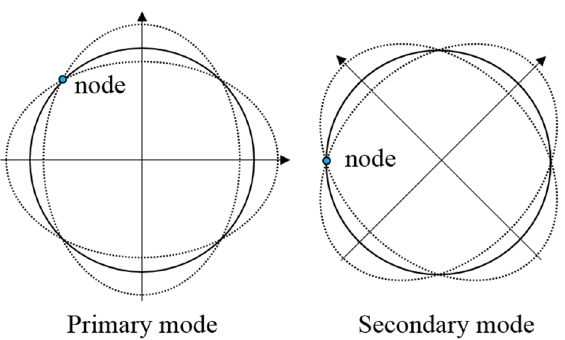
Figure 1. The 2 θ mode pair of the ring-based gyroscope with elliptic mode shapes consisting of four nodes and four anti-nodes.